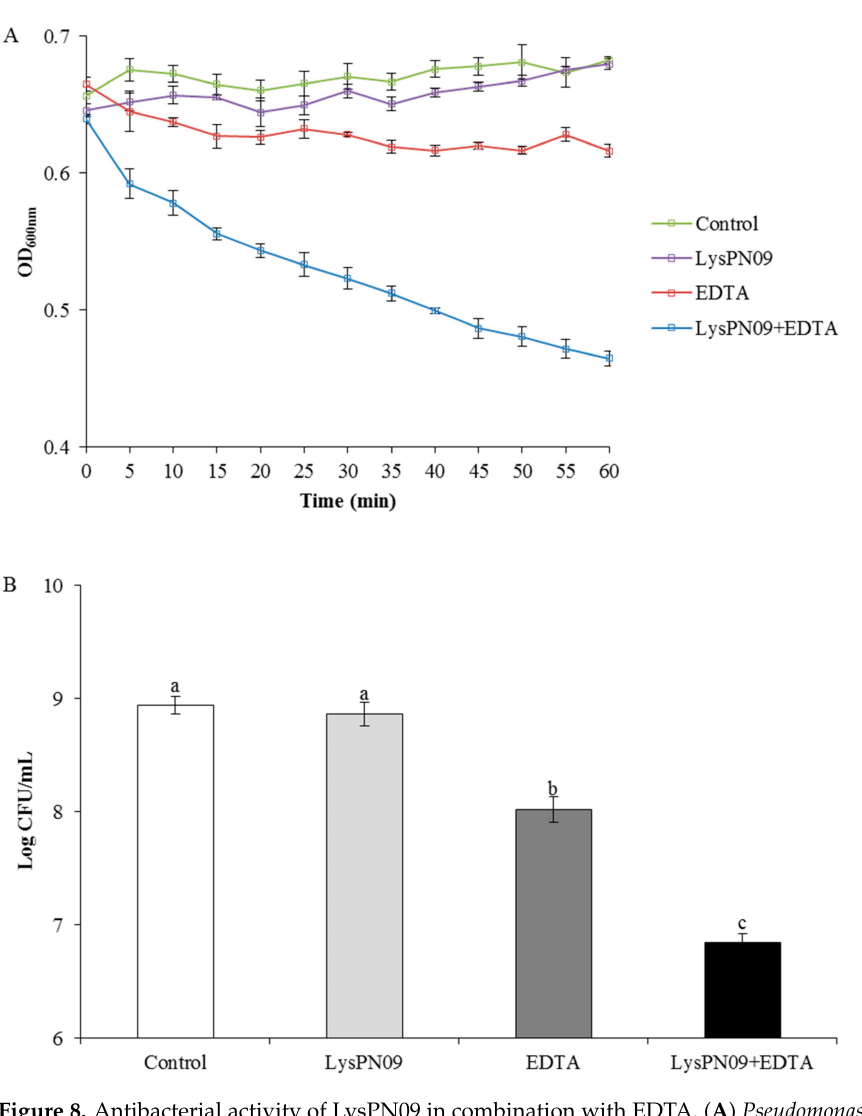
Figure 8. Antibacterial activity of LysPN09 in combination with EDTA. ( A ) Pseudomonas syringae pv. actinidiae (Psa) strain SCJY02-1 was treated with LysPN09 (final concentration: 400.0 µ g/mL), EDTA (final concentration: 1.0 mM), and LysPN09 + EDTA (final concentration: 400.0 µ g/mL and 1.0 mM, respectively). The control contained 50.0 µ L of PBS buffer (pH 7.4) instead of LysPN09 or EDTA. The OD 600 values of Psa were measured every 5 min for 60 min. ( B ) After 60 min of incubation, the residual viable cells were plated and measured. Shared letters above bars indicate no statistical difference among groups ( p > 0.05) and different letters above bars indicate a statistically significant difference ( p <